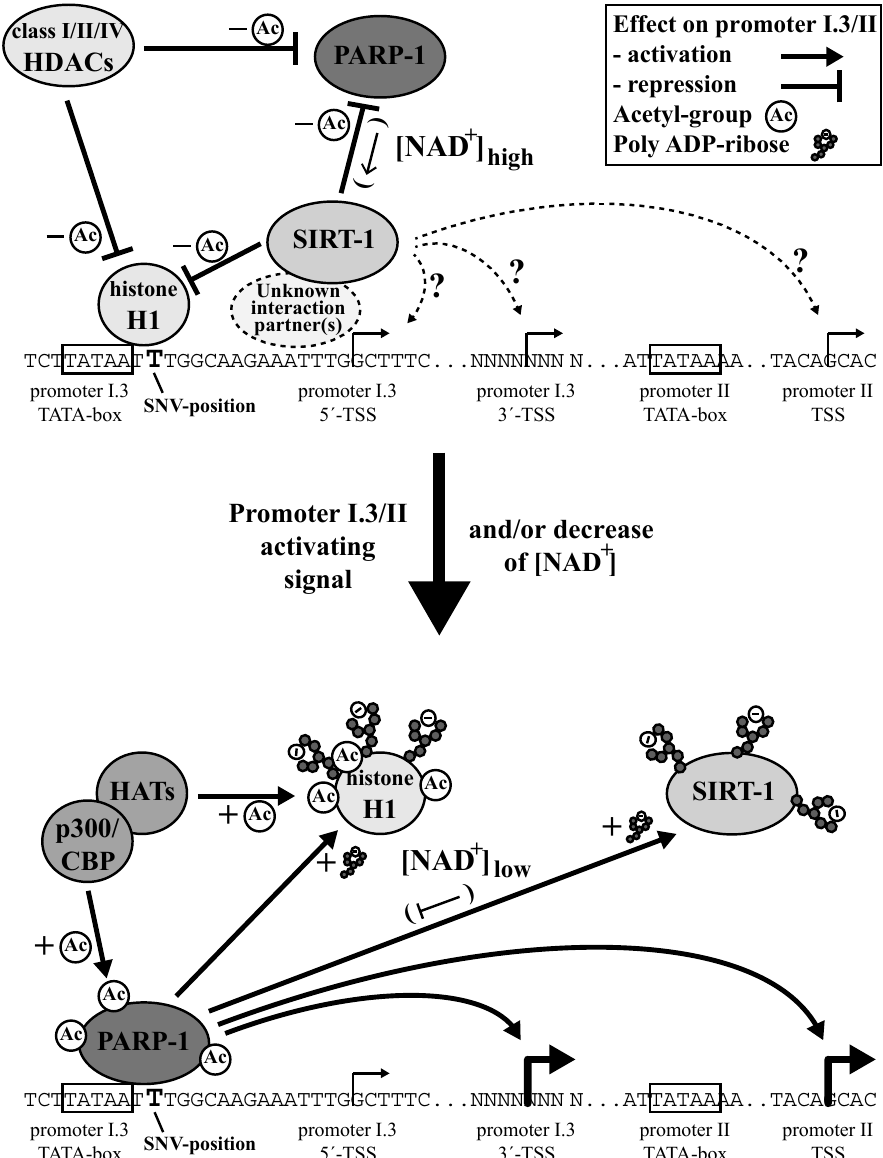
Figure 7. Model of PARP-1-dependent aromatase promoter I.3 / II regulation. The aromatase promoter I.3 / II-region is predominantly occupied by histone H1 and SIRT-1 (in concert with other HDACs) in un-stimulated BAFs. Signals activating promoter I.3 / II trigger p300 / CBP- or other histone acetyltransferase (HAT)-mediated acetylation of PARP-1 and H1. The resulting PARP-1 binding and activation boost displacement of H1 and SIRT-1 from the promoter by parylation. SIRT-1 activates promoter I.3 / II by an unknown mechanism and, at high NAD + -concentrations, inhibits PARP-1 by deacetylation. Low NAD + -concentrations in tumor-associated BAFs favor PARP-1-activation and perpetuate H1- and SIRT-1-displacement.